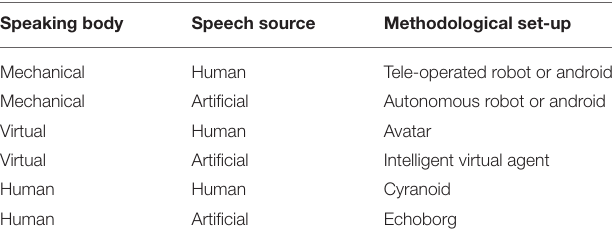
TABLE 1 | Taxonomy of body and speech source combinations with associated